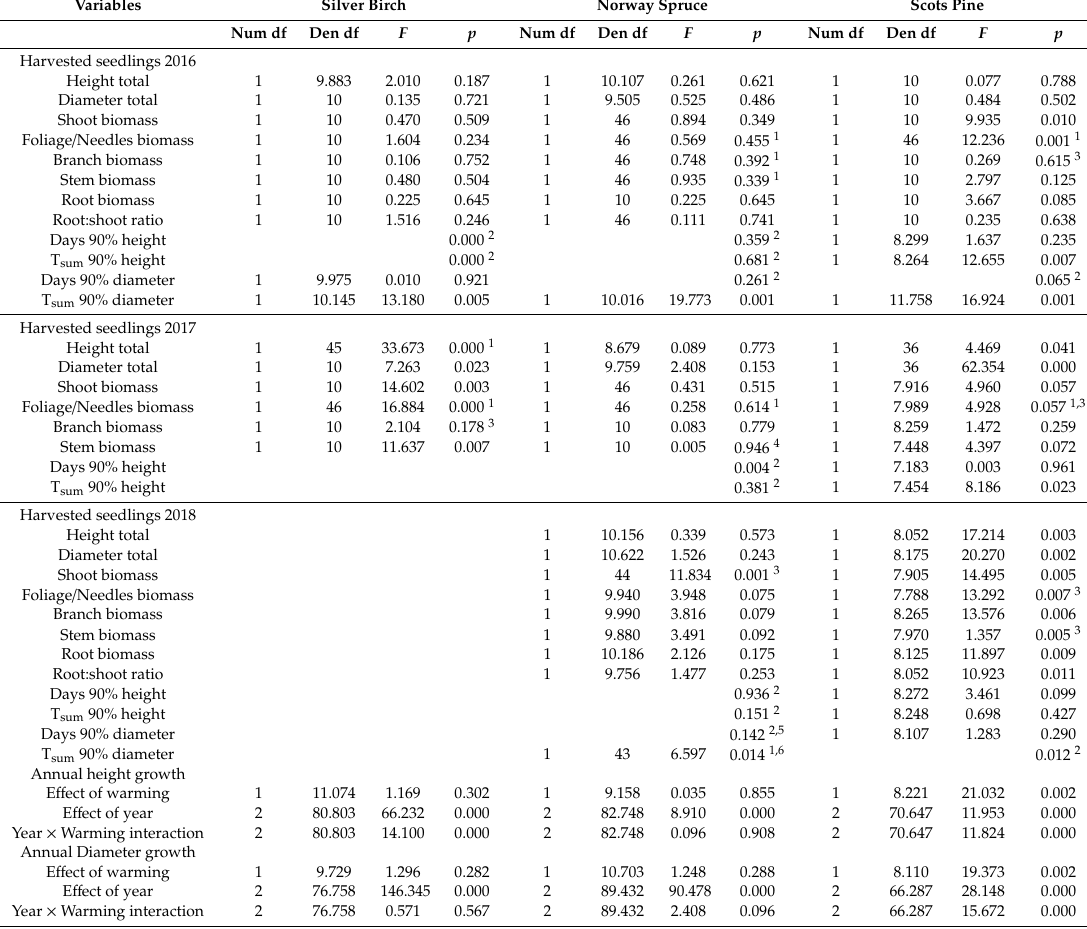
Table 3. Results of the linear mixed-e ff ect model and the repeated function of the same model for the e ff ect of the warming treatment and year, and their interaction on di ff erent growth parameters in silver birch, Norway spruce and Scots pine seedlings harvested in 2016, 2017 and 2018. The total height and diameter values are given separately for seedlings harvested in di ff erent years (2016, 2017 and 2018). The annual height and diameter growth values over years 2016–2018 represent seedlings harvested in 2018. df = degrees of freedom, num df = numerator degrees of freedom, den df = denominator degrees of freedom, F = value on the F distribution, p = probability of rejecting the null